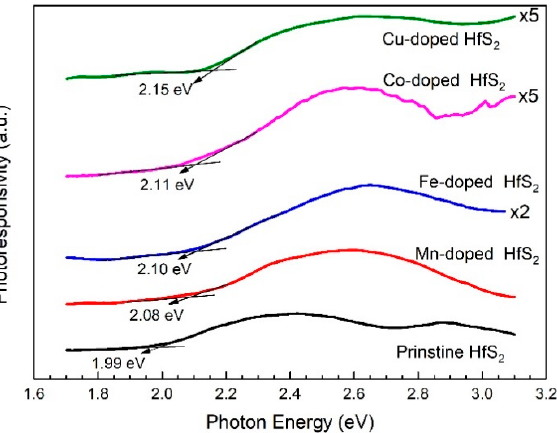
Figure 3. Photoconductivity spectra of the pristine, Mn-, Fe-, Co-, and Cu-doped HfS 2 crystals. 1.99, 2.08, 2.10, 2.11, and 2.15 eV, respectively. These values were close to those spec-